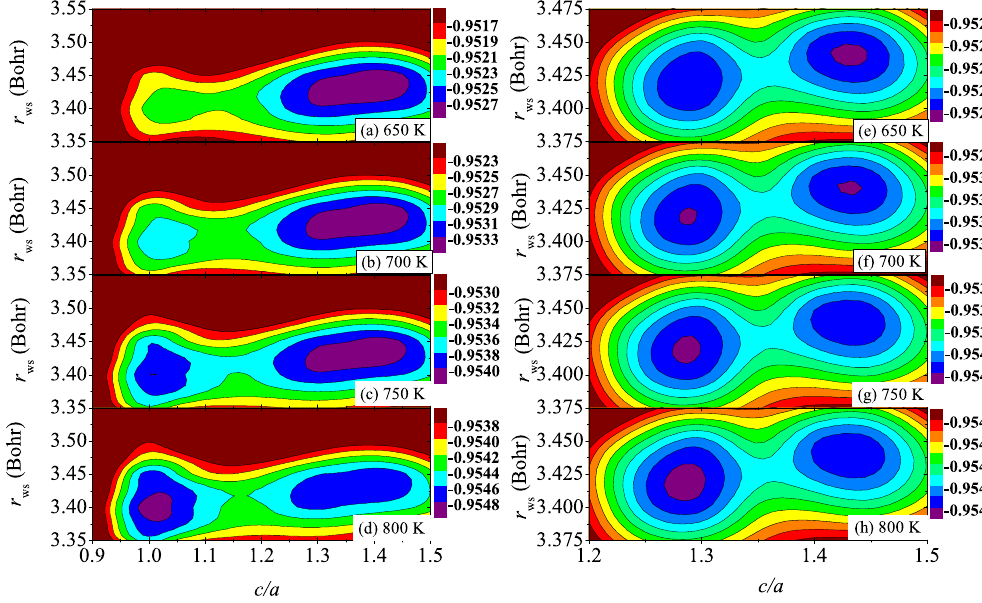
Figure 5. Free energy ( = − + + − F E TS F E TS , in unit of Ry) change with respect to the el el vib mag mag Wigner-Seitz radius ( r ws ) and c / a of Pu using 10% reduced μ Pu . Results are shown for 650 K ( a , e ), 700 K ( b , f ), 750 K ( c , g ), and 800 K ( d , h ), respectively. The three minima correspond to the δ , δ ′ , and ε phases in the left panel, whereas in the right panel, the two minima indicate the δ and δ ′